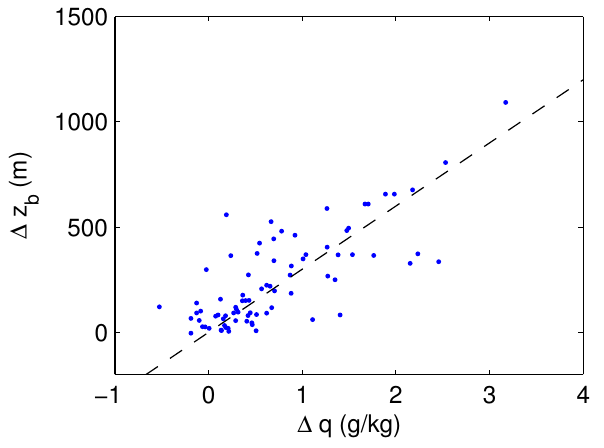
Fig. 6. The profile moisture decoupling index 1q and the decou- pling measurement from the adjacent subcloud leg 1z b are consis- tent metrics for determining decoupling. The dashed black line has slope 150m per 0.5 (gkg − 1 ).